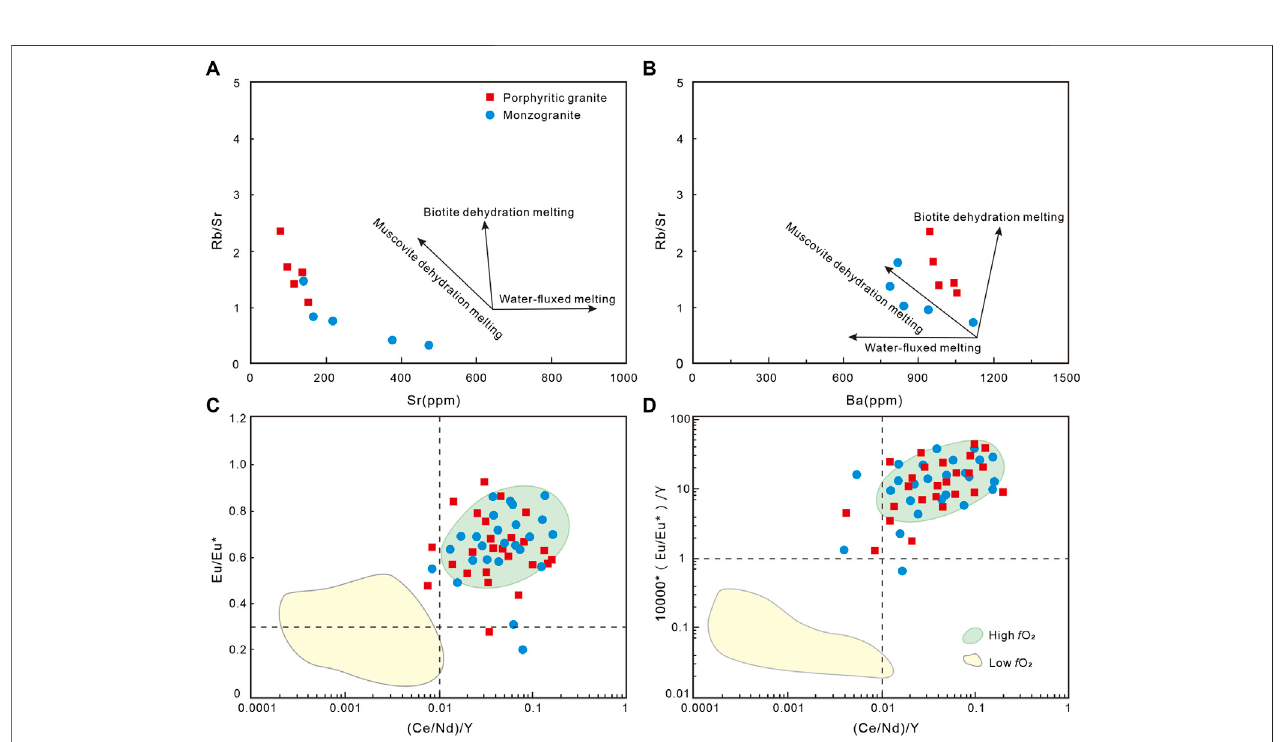
FIGURE 11 | Sr vs. Rb/Sr diagram [ (A) after Inger and Harris, 1993], Ba vs. Rb/Sr diagram [ (B) after Inger and Harris, 1993], 10,000*(Eu/Eu*)/Y vs. (Ce/Nd)/Y (C) , and (Eu/Eu*)/Y vs. (Ce/Nd)/Y (D) plots for zircons from Yaozhuang stock [ (C , D) after Lu et al., 2016].